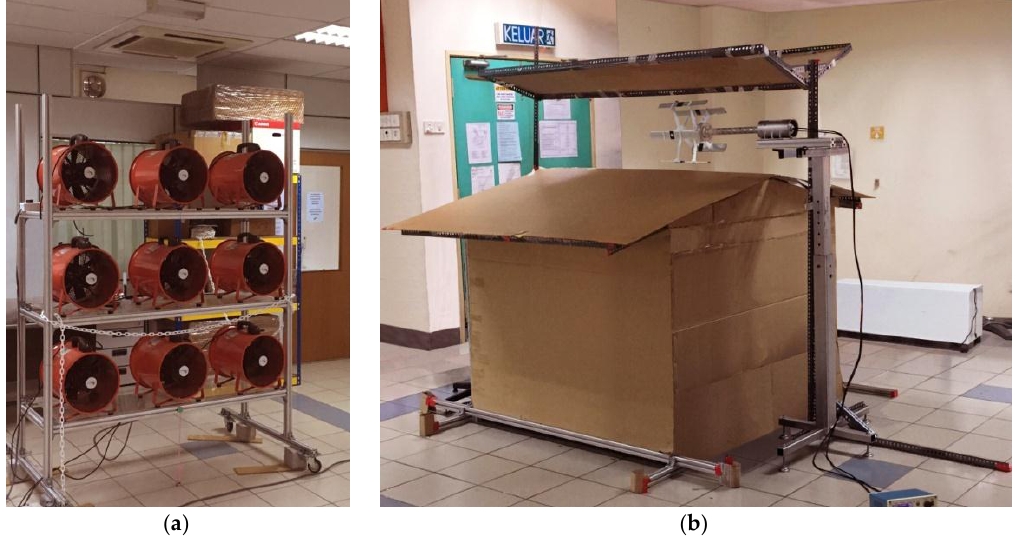
Figure 11. ( a ) Ventilation fans; ( b ) Indoor experimental set-up of a VAWT integrated with VRGV on top of a double slope roof.